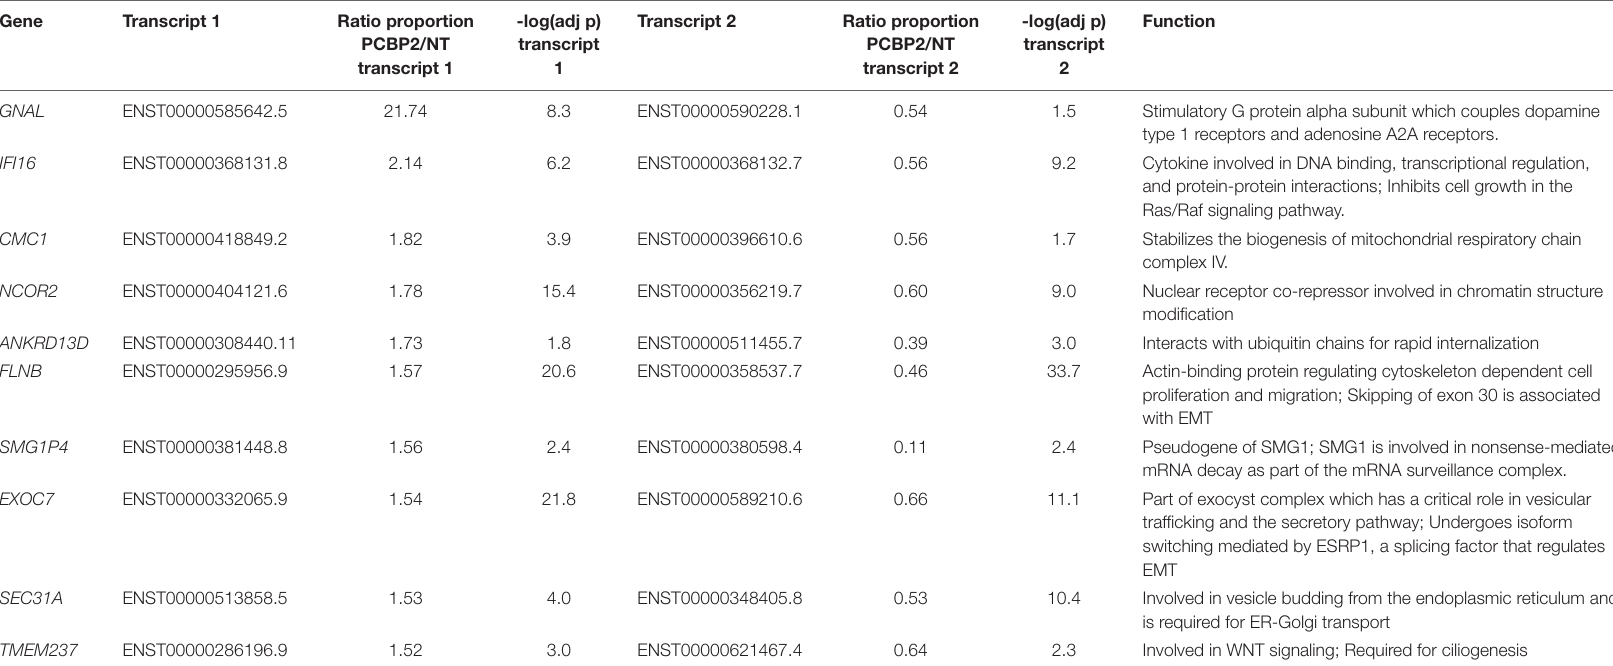
TABLE 2 | Differentially spliced